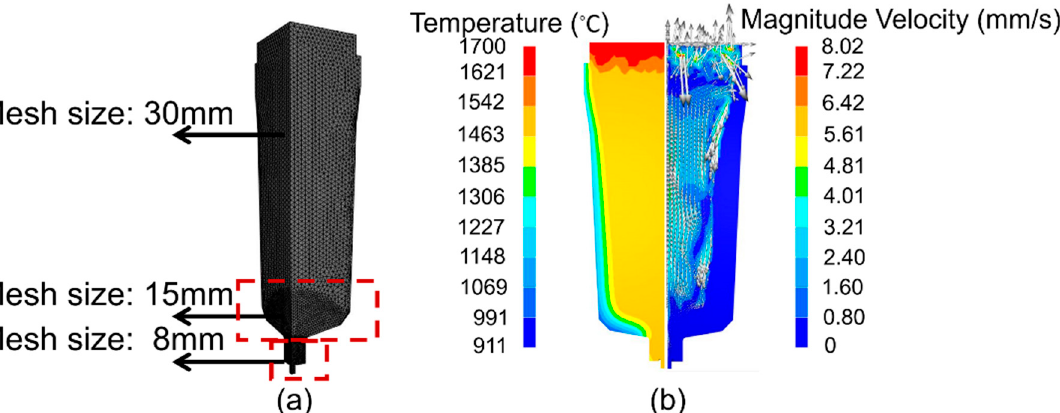
Figure 3. ( a ) Mesh distribution of the 90° model, ( b ) The temperature pattern on the left side and the velocity pattern on the right side after ignition of exothermic caps at the end of filling . Table 2. Input parameters for the simulation .